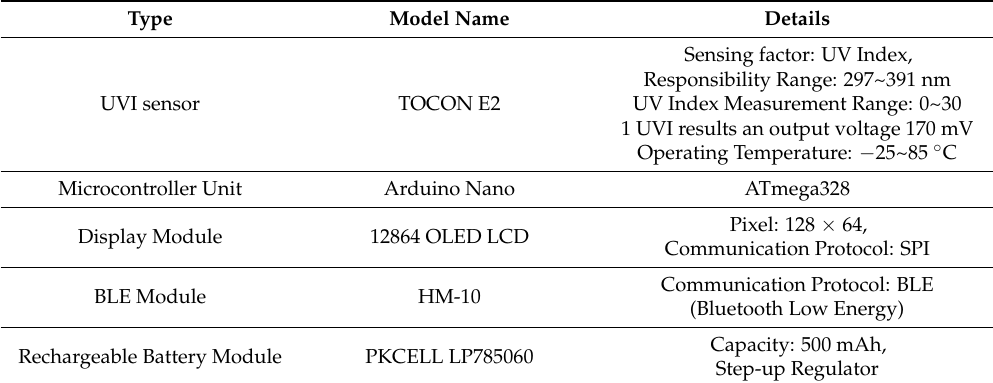
Table 1. Hardware specifications .